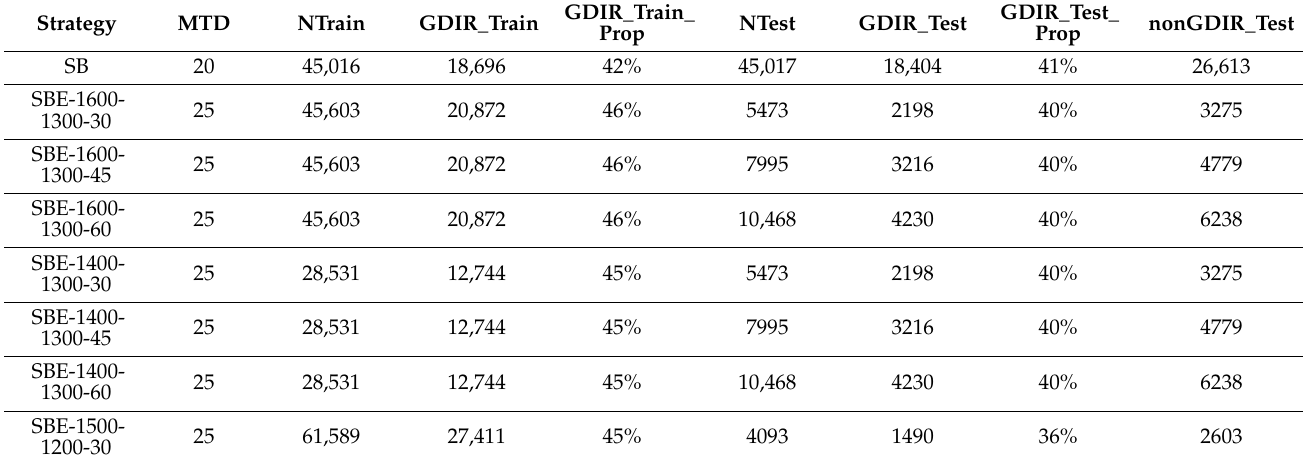
Table 1. Data characterization for various evaluation